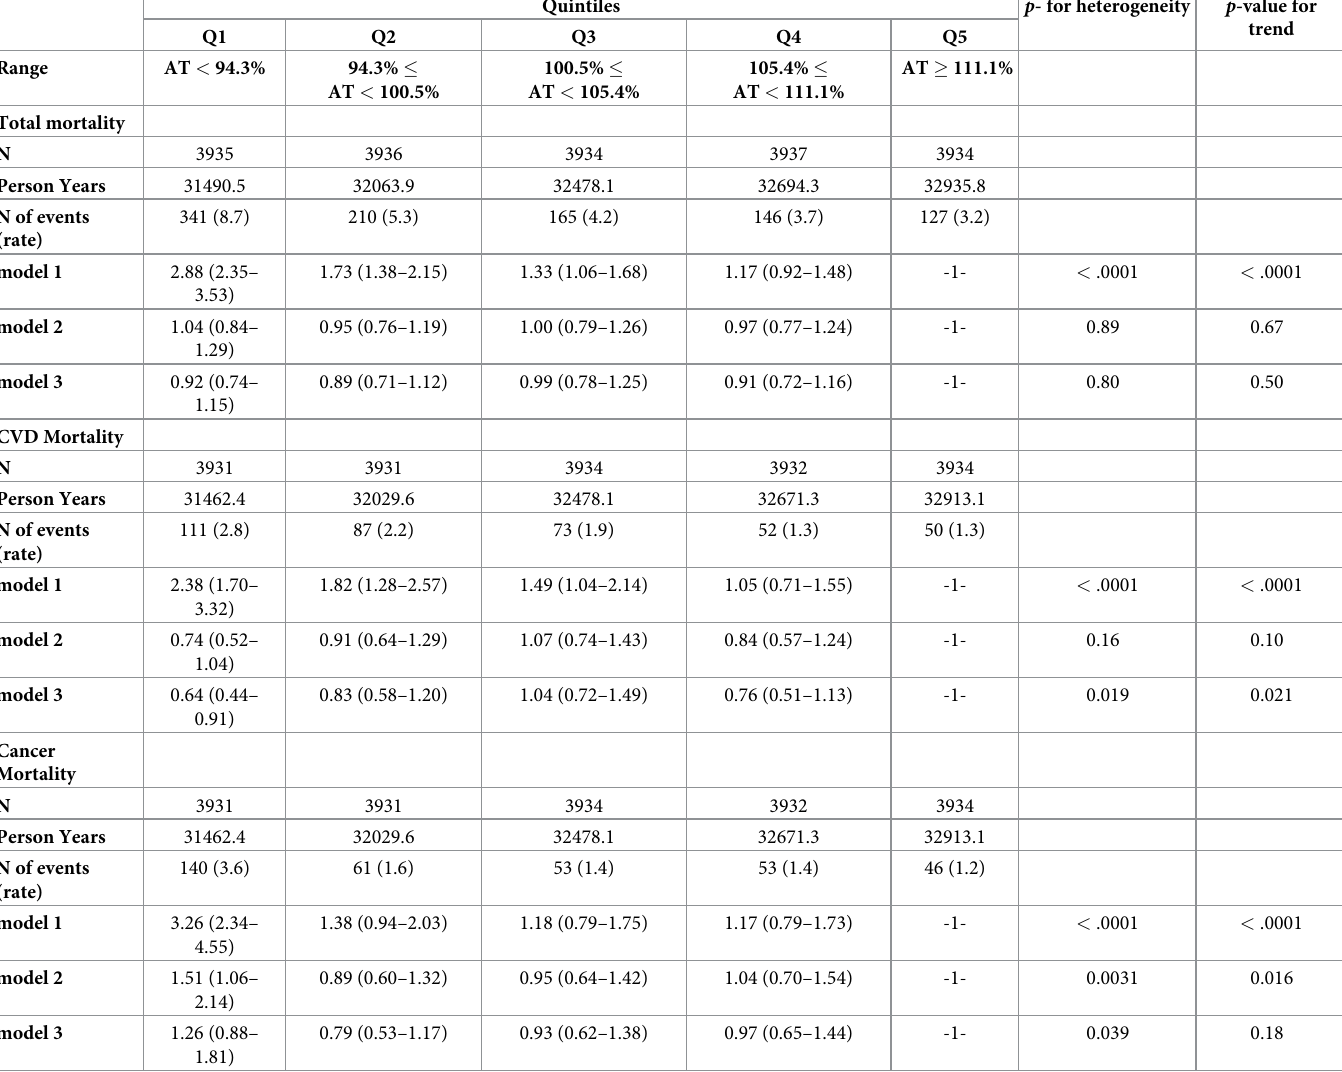
Table 2. Incidence and hazard ratios (95% CI) for total, cardiovascular and cancer mortality according to quintiles of AT %, in the Moli-sani population (n =